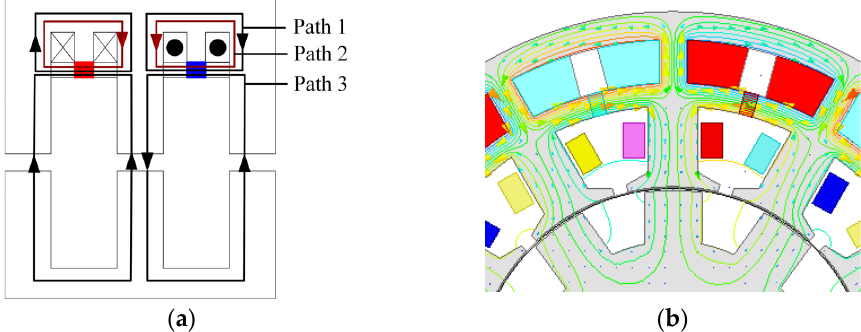
Figure 4. Magnetic flux paths of hybrid excitation when J f < J f 0 : ( a ) theoretical paths; ( b ) FEA paths.